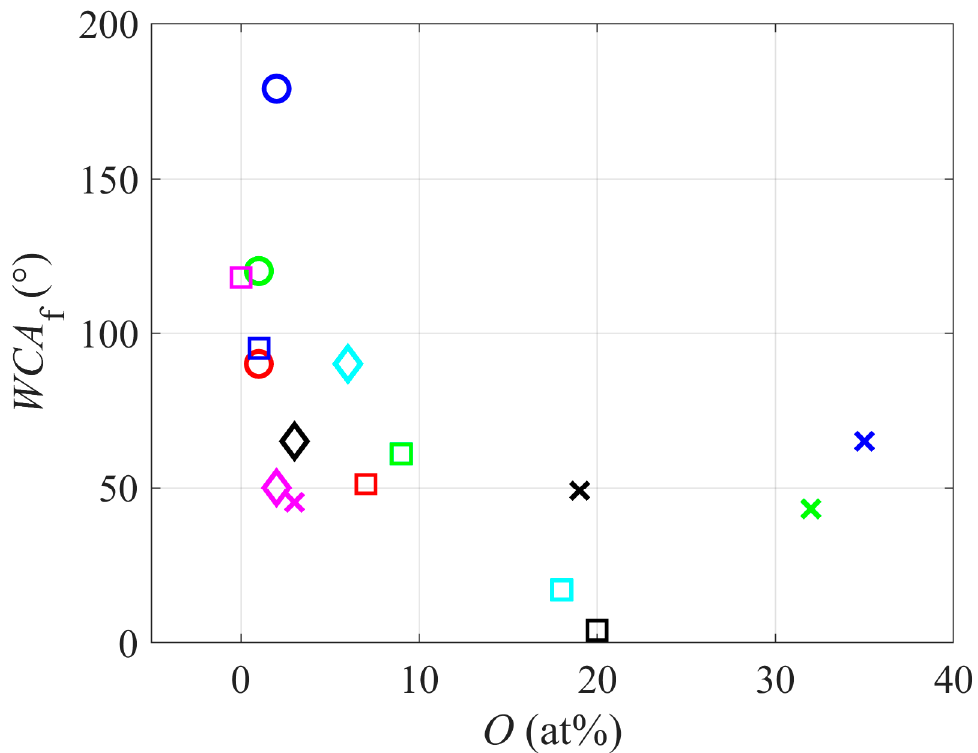
Figure 4. Water contact angle versus the concentration of oxygen in the polymer surface film.